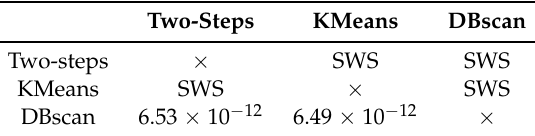
Table 24. p -values for instance